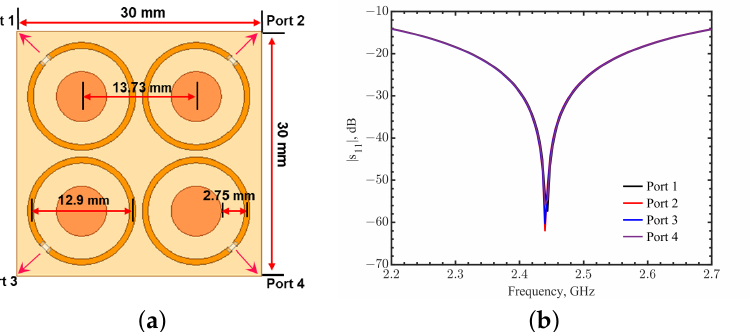
Figure 16. ( a ) The phased array loop structure consisting of four tuned loops in a mirrored configu- ration. The phase difference was 180 ◦ between the neighbor elements. ( b ) Simulations of reflection coefficients for ports 1–4 in the tuned phased loop